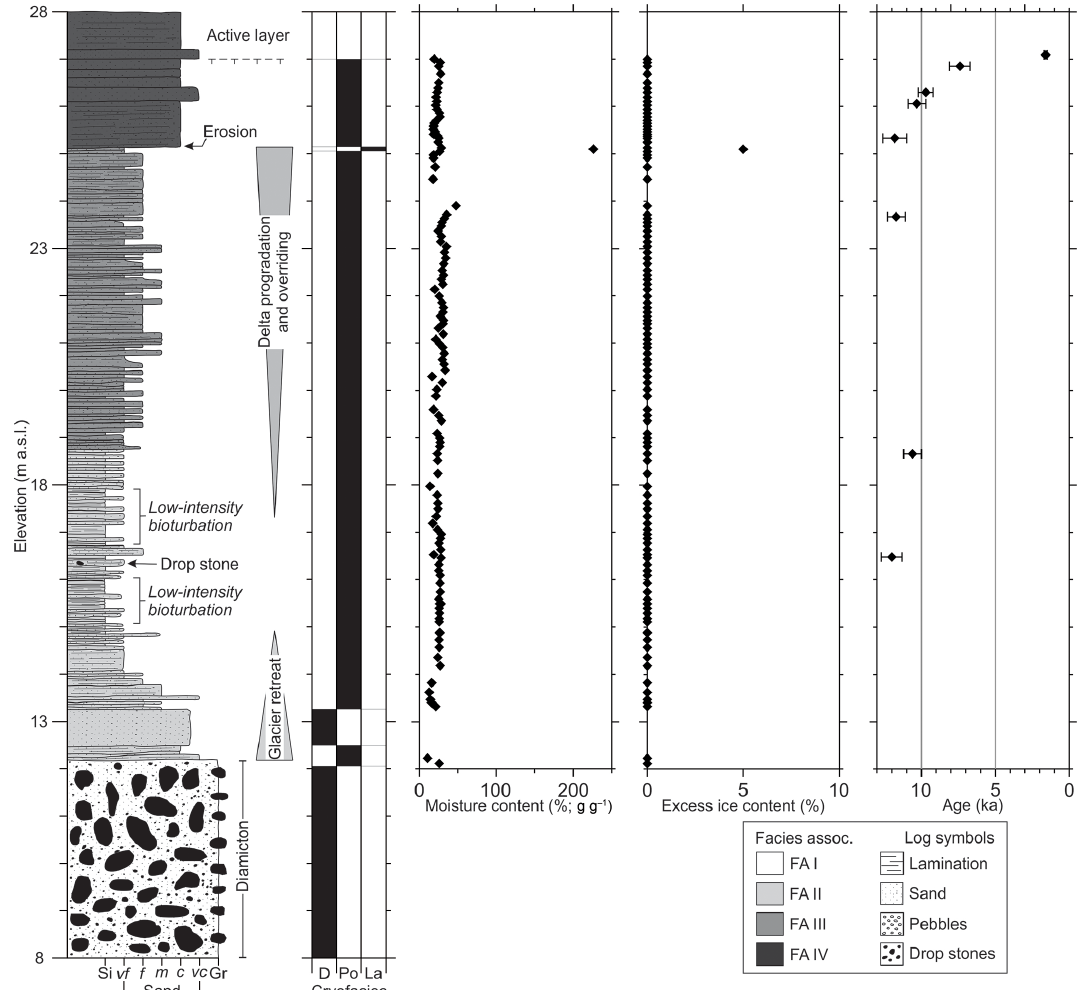
Figure 8. Log for C2 illustrating vertical variations in sediment grain size, facies associations, ground-ice characteristics, and OSL ages. D, Po, and La denote disturbed sections, pore, and layered cryofacies, respectively. Note the difference in axis range compared with Fig.